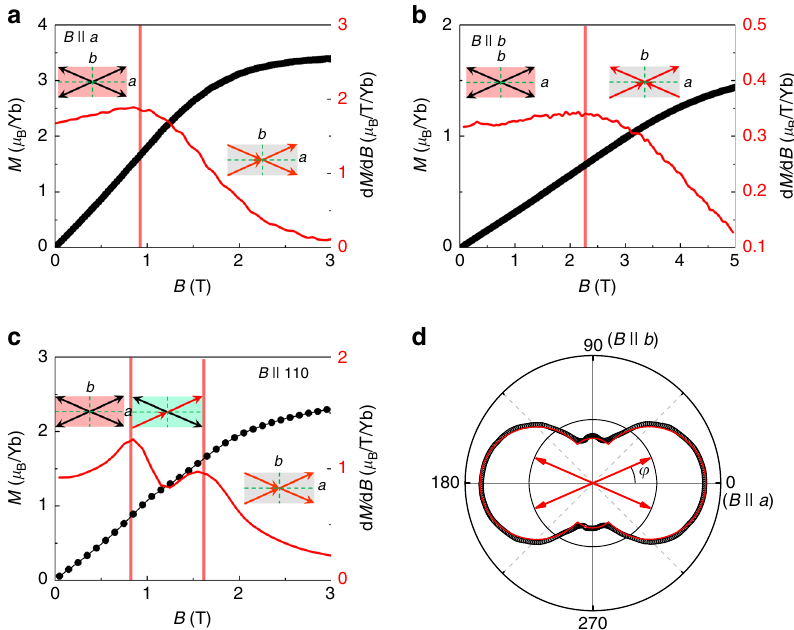
Fig. 1 Single-ion anisotropy of YbAlO 3 . a – c Field-dependent magnetization M (black circles) and magnetic susceptibility d M /d B (red line) of YbAlO 3 , measured at T = 2 K with fi eld along the axes B || a , B || b and B || [110], as indicated. The insets are sketches of the magnetic moment con fi gurations in different fi eld ranges. d Angle-dependent magnetization measured at T = 2 K and B = 5 T. Red arrows schematically show a moment con fi guration of Yb 3 + at zero fi eld with angle φ = 23.5° between the a -axis and the Yb magnetic moment. The solid line is the calculation, as described in the